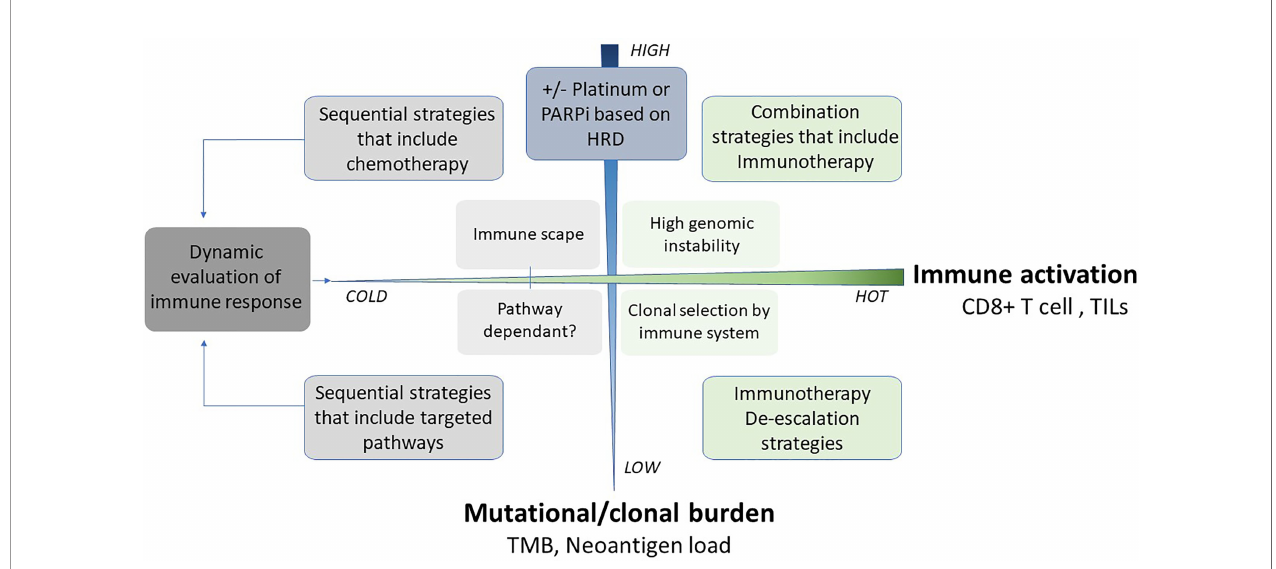
FIGURE 3 | Proposed framework for the personalised treatment of early.